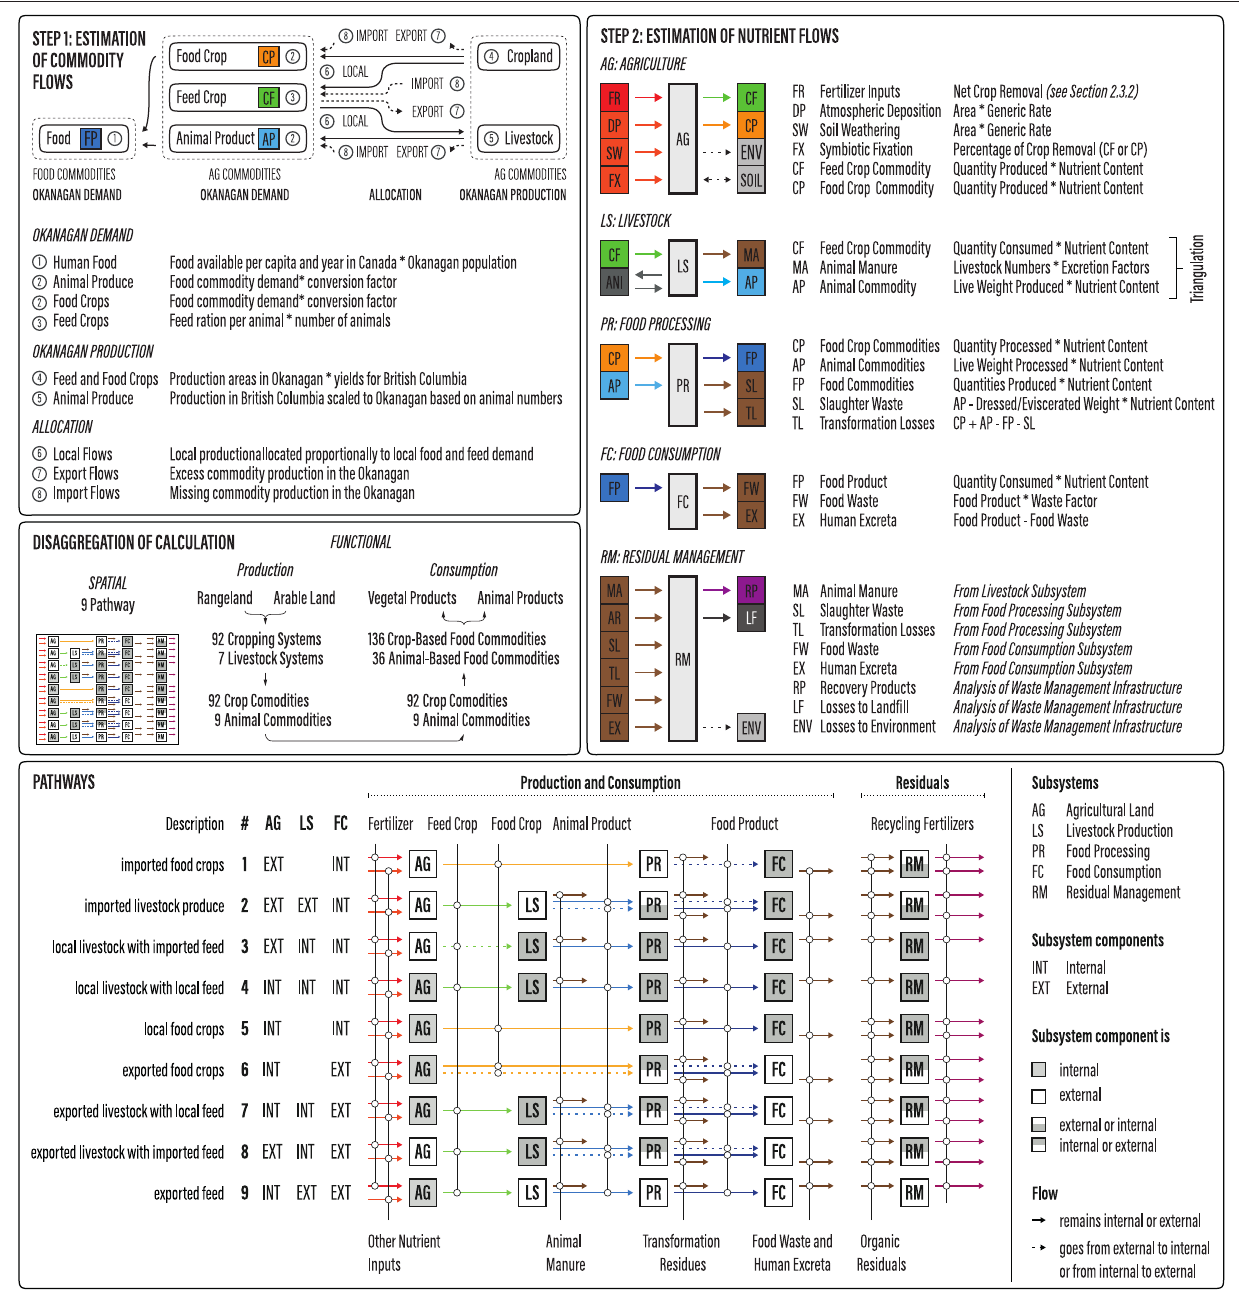
the calculations did not account for this. Unlike in the case